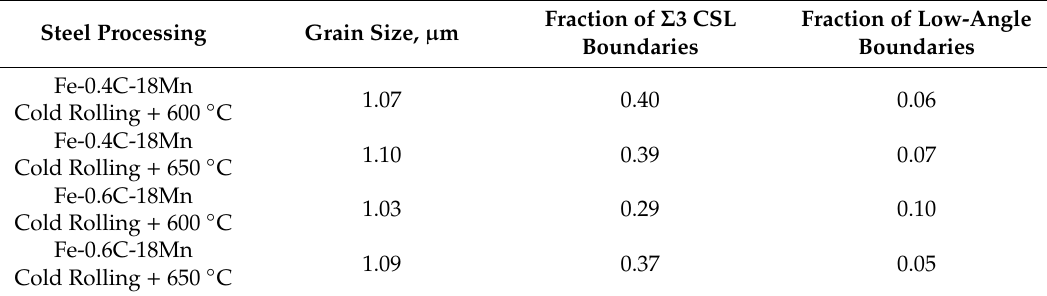
Figure 3. Typical microstructures in Fe-0.4C-18Mn and Fe-0.6C-18Mn steels (0.4C and 0.6C, respectively) subjected to cold rolling and annealing at indicated temperatures. High-angle grain boundaries and Σ 3 CSL boundaries are indicated by the black and white lines, respectively. The colors correspond to crystallographic direction along ND. Table 1. Some parameters of the annealed microstructures.